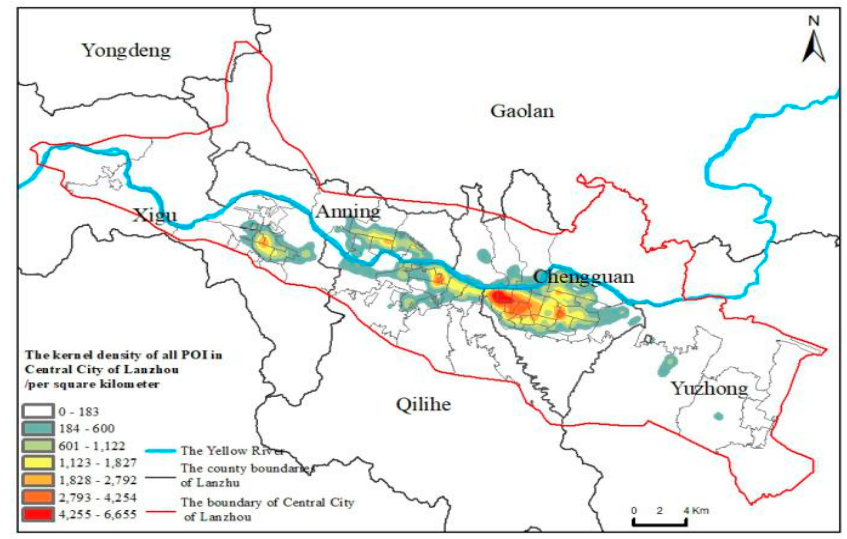
Figure 4. The kernel density distribution of all types of economic geographical elements.